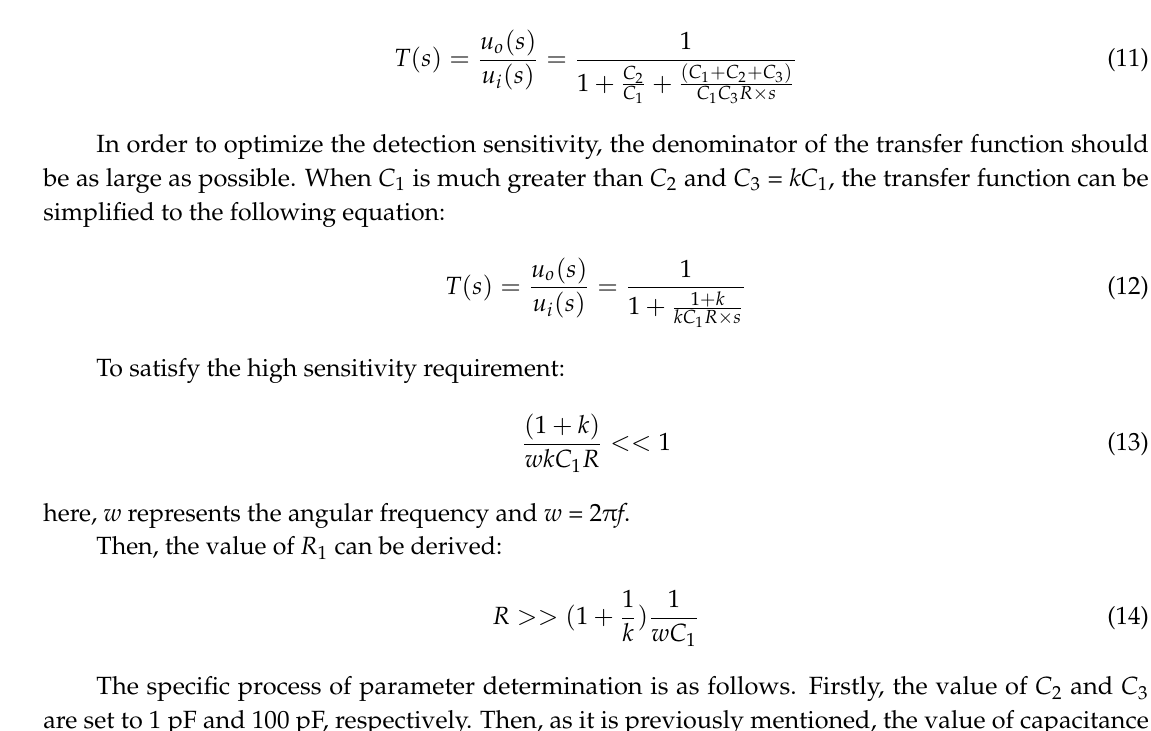
Figure 3. Circuit schematic of the TEV sensing unit.